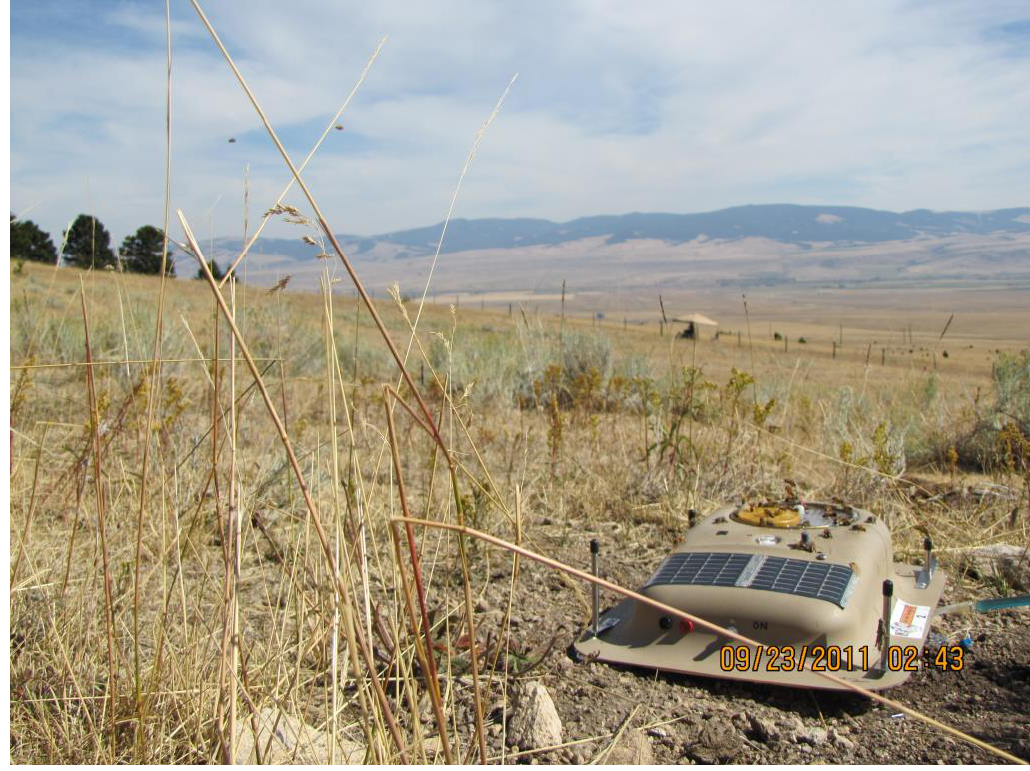
Figure 2. Solar-powered, micro-processor-controlled bee-conditioner system with scent and reward (proprietary syrup solution) dispensing systems. Reward intervals can be controlled automatically by the device, re-programmed as needed, or remotely controlled